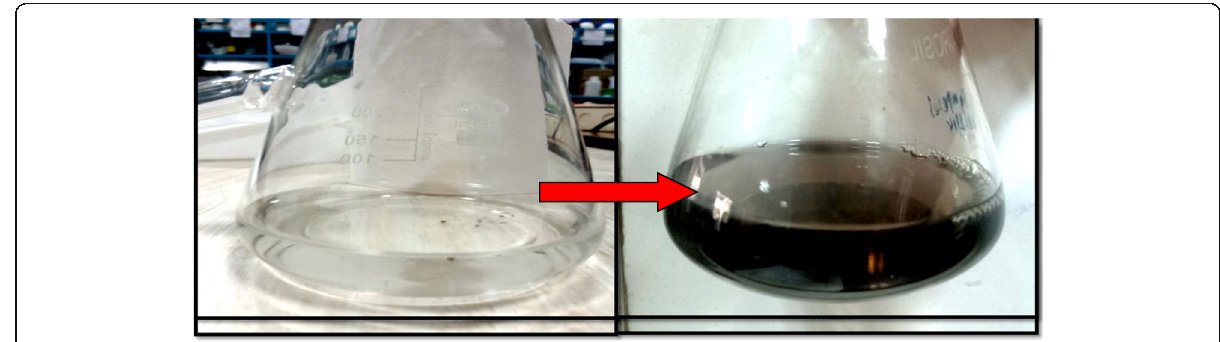
Fig. 1 The colour change was observed from colourless with the addition of extract and precursor to a dark brown solution when kept for incubation for 8